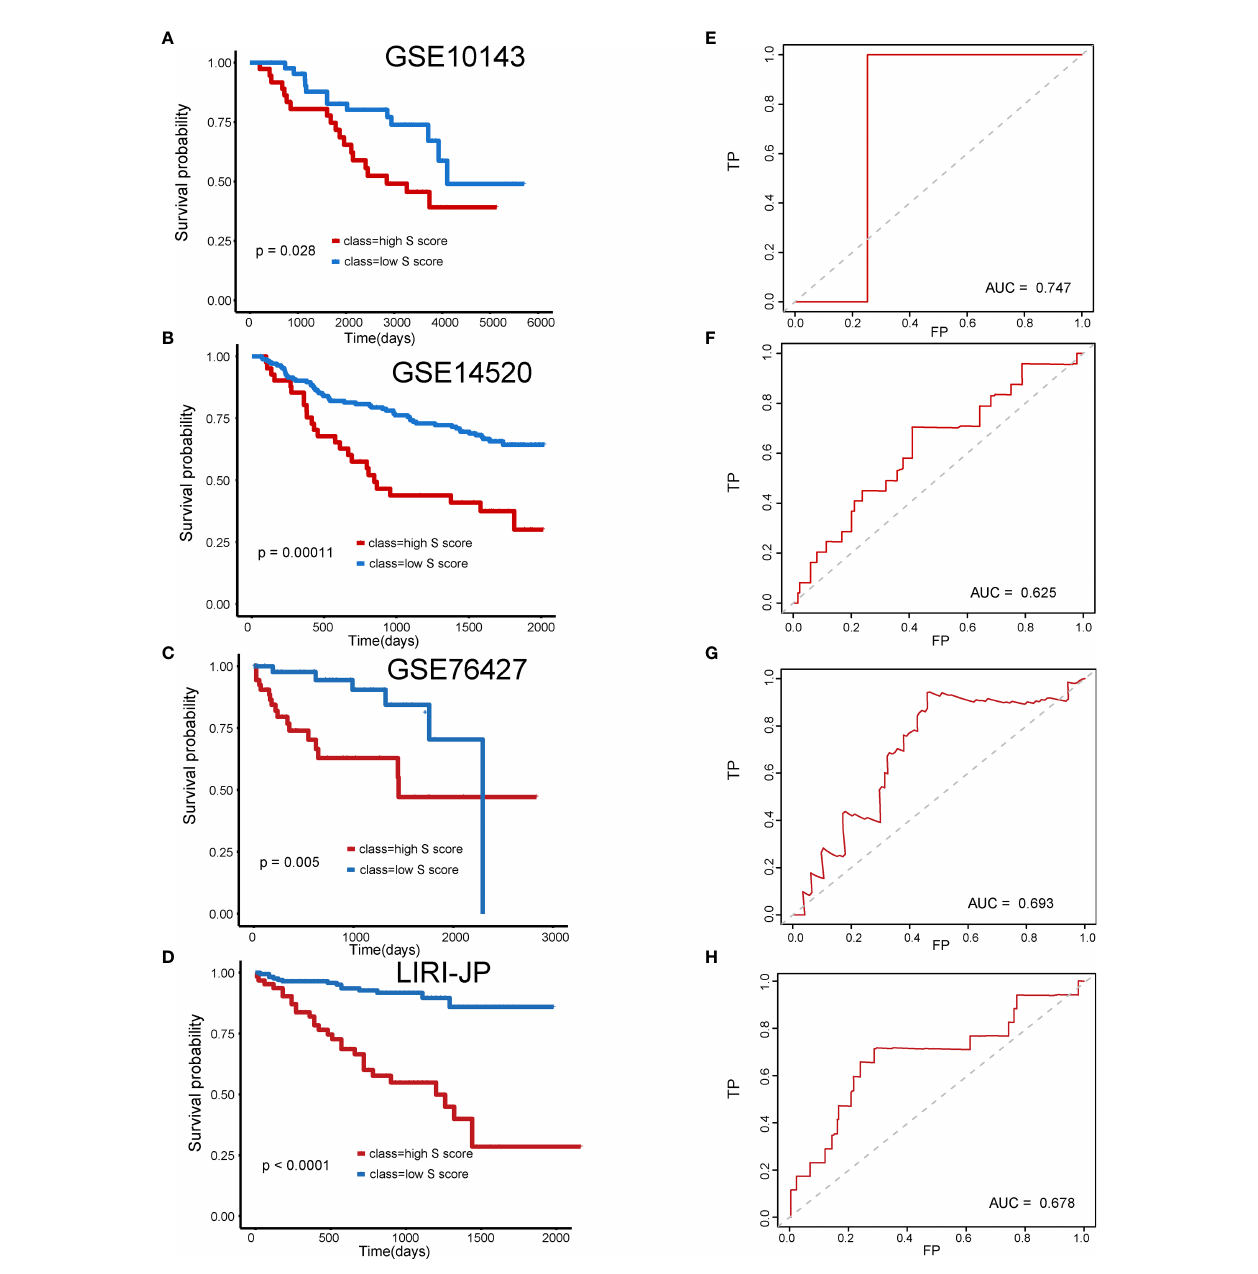
FIGURE 5 | Validation of the prognostic ef fi ciency of S score in external datasets. (A) Overall survival of patients in GSE10143. (B) Overall survival of patients in GSE14520. (C) Overall survival of patients in GSE76427. (D) Overall survival of patients in LIRI-JP. (E) AUC curve of the patients with HCC in the GSE10143. (F) AUC curve of the patients with HCC in the GSE14520. (G) AUC curve of the patients with HCC in the GSE76427. (H) AUC curve of the patients with HCC in the